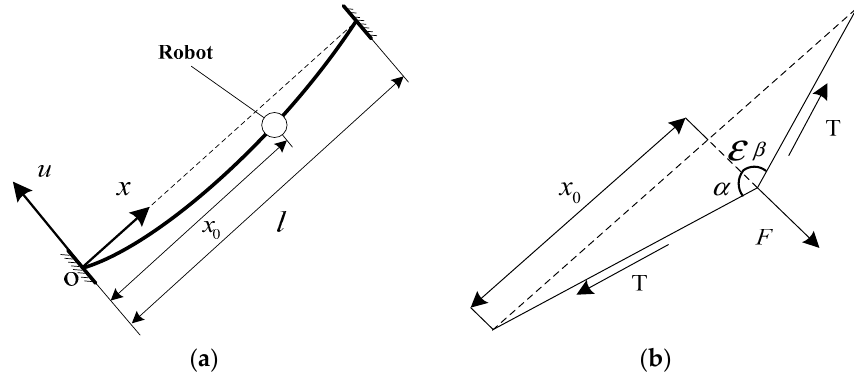
Figure 10. Robot–cable dynamic analysis. ( a ) Schematic diagram of cable vibration; ( b ) Force applied on the robot.